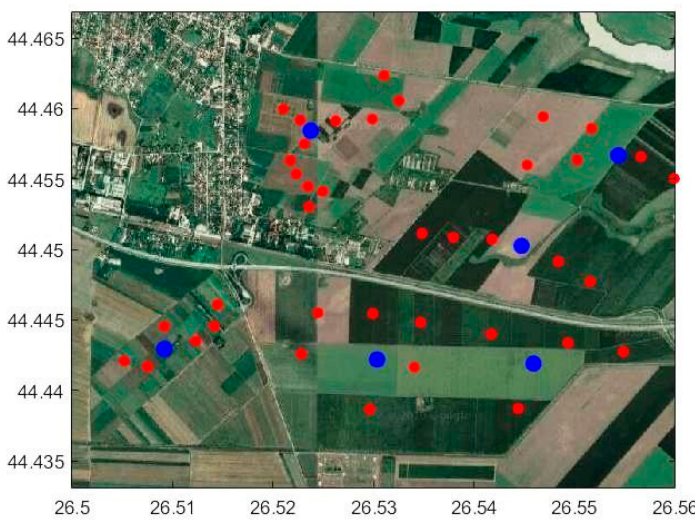
Figure 14. Study area with the corresponding sensor nodes (red disks) and cluster heads (blue disks).